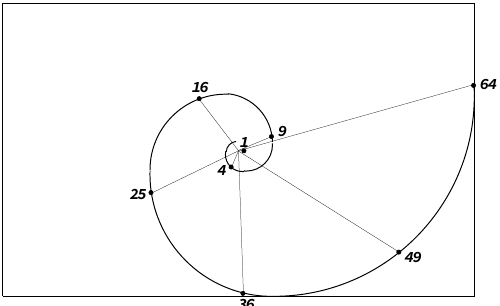
Figure 4. Predicted radii of electron shells as a function of n